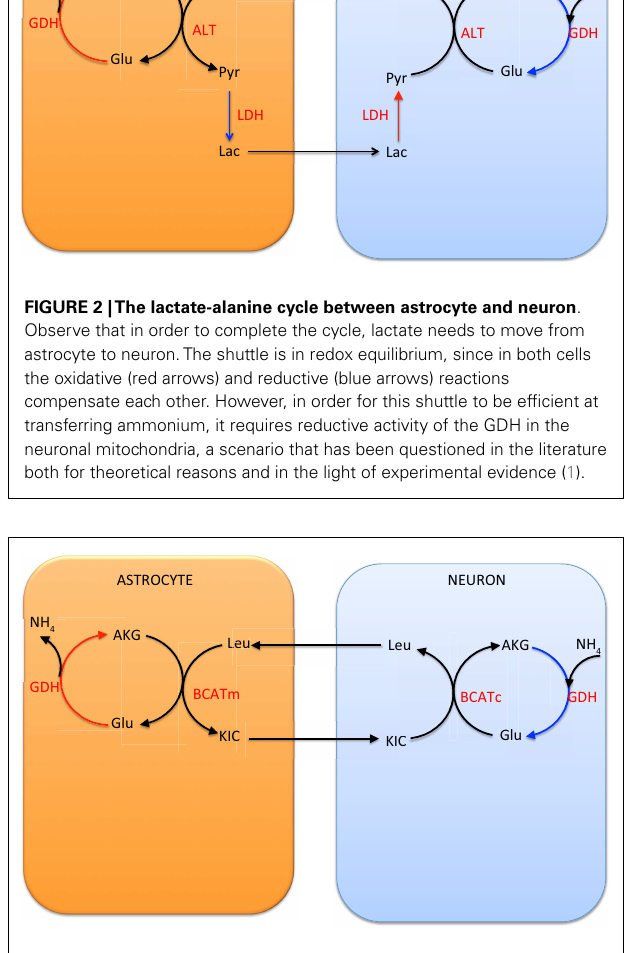
4. both NH + and leucine are assumed to be replenished 4